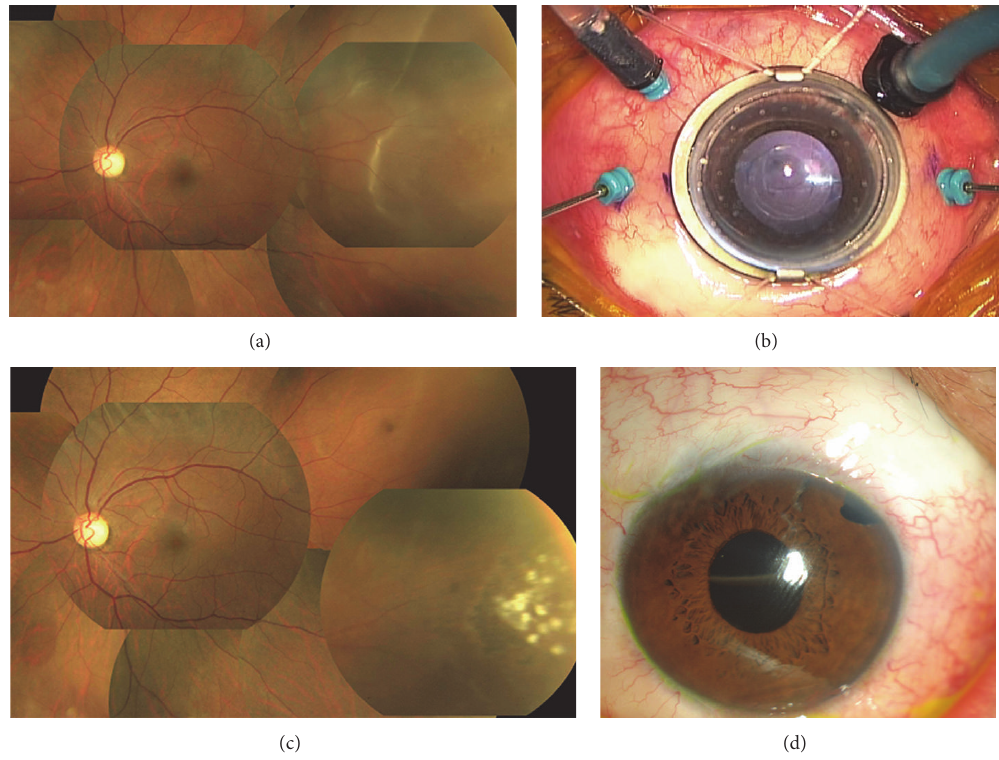
Figure 2: Representative example of rhegmatogenous retinal detachment (RRD) (Patient 1; see Table 1). Fundus, anterior segment, and intraoperative photographs of the eye of a 45-year-old man with RRD. The eye underwent 25-gauge microincision vitrectomy surgery (25GMIVS) after trabeculectomy. (a) Preoperative photograph of the fundus. There was focal retinal detachment with a peripheral retinal tear. (b) Intraoperative photograph of the anterior segment. 25GMIVS was being performed with 4 ports. The insertion placement of the cannulas was shifted to avoid disturbing the subconjunctival hemorrhage of the filtering bleb in the upper temporal region. (c) Postoperative photograph of the fundus. Retinal reattachment was achieved with 25GMIVS. The white retinal scars of endophotocoagulation can be seen. (d) One-day postoperative photograph of the anterior segment. There was no subconjunctival hemorrhage, including the filtering bleb, in the upper temporal region. An air-fluid level line of intraocular gas tamponade can be seen through the